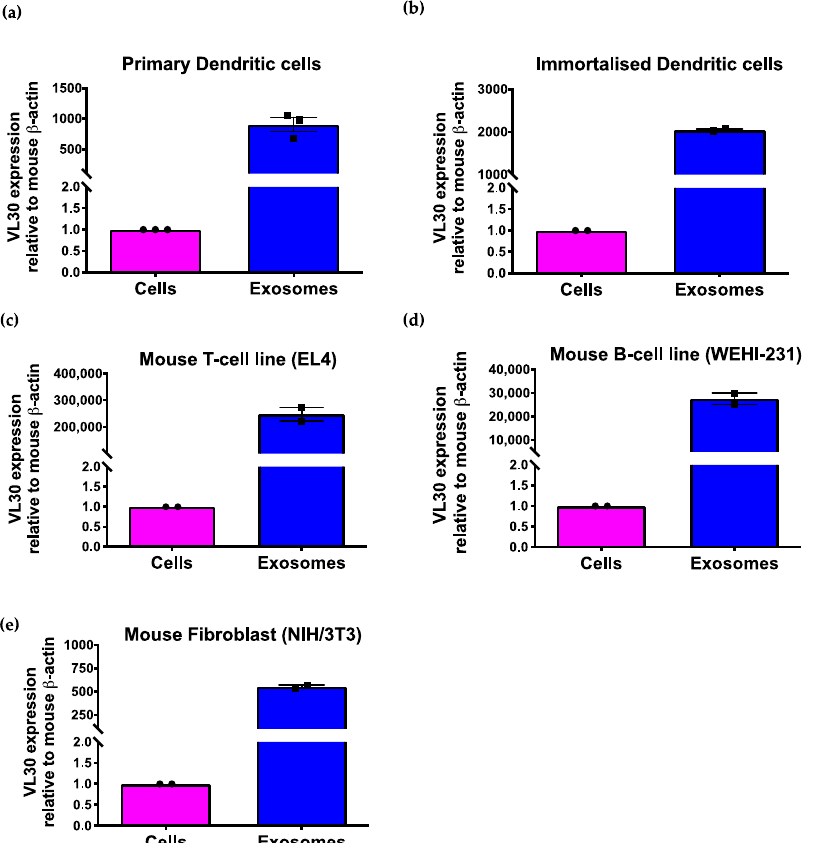
Figure 2. VL30 RNA is enriched in SEVs from multiple cell types. Relative abundance of VL30 RNA normalized to β -actin in cells and SEVs for ( a ) primary dendritic cells, ( b ) immortalized dendritic cells, ( c ) T cells, ( d ) B cells and ( e ) fibroblasts. Data shown are averages of three independent experiments. Error bars represent SEM.